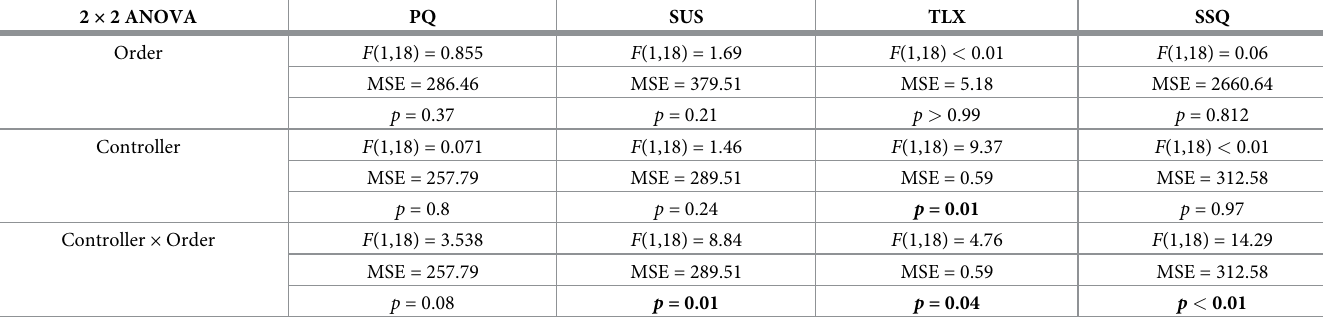
Table 3. Questionnaire results from Experiment 2. Significant results ( p < 0.05) are bold.